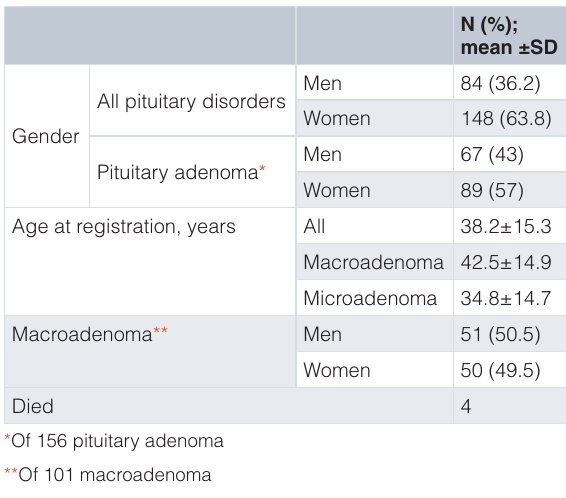
Table 1. Pituitary disorders patients demography and